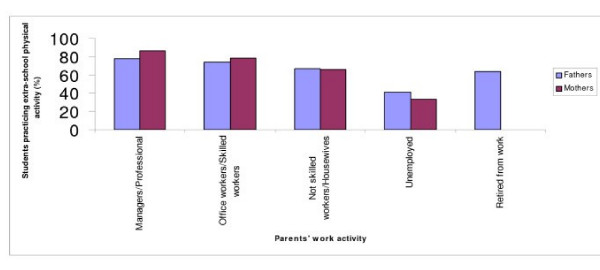
Relation between students' extra-school physical activity and parents' work activity.